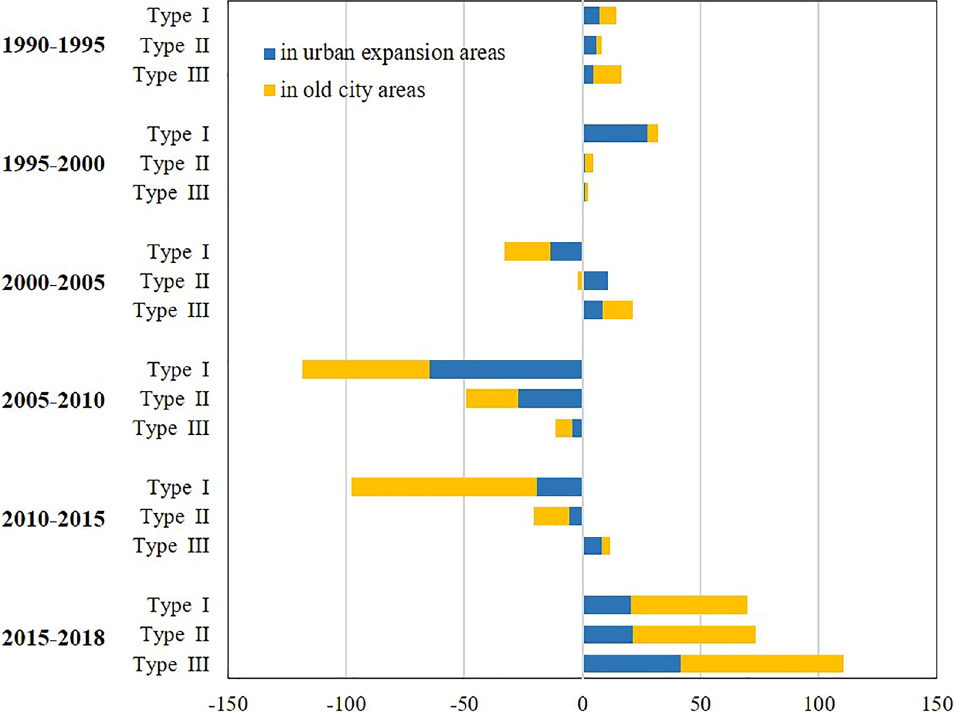
Figure 5. Urban waterbody variation for each period for the three city